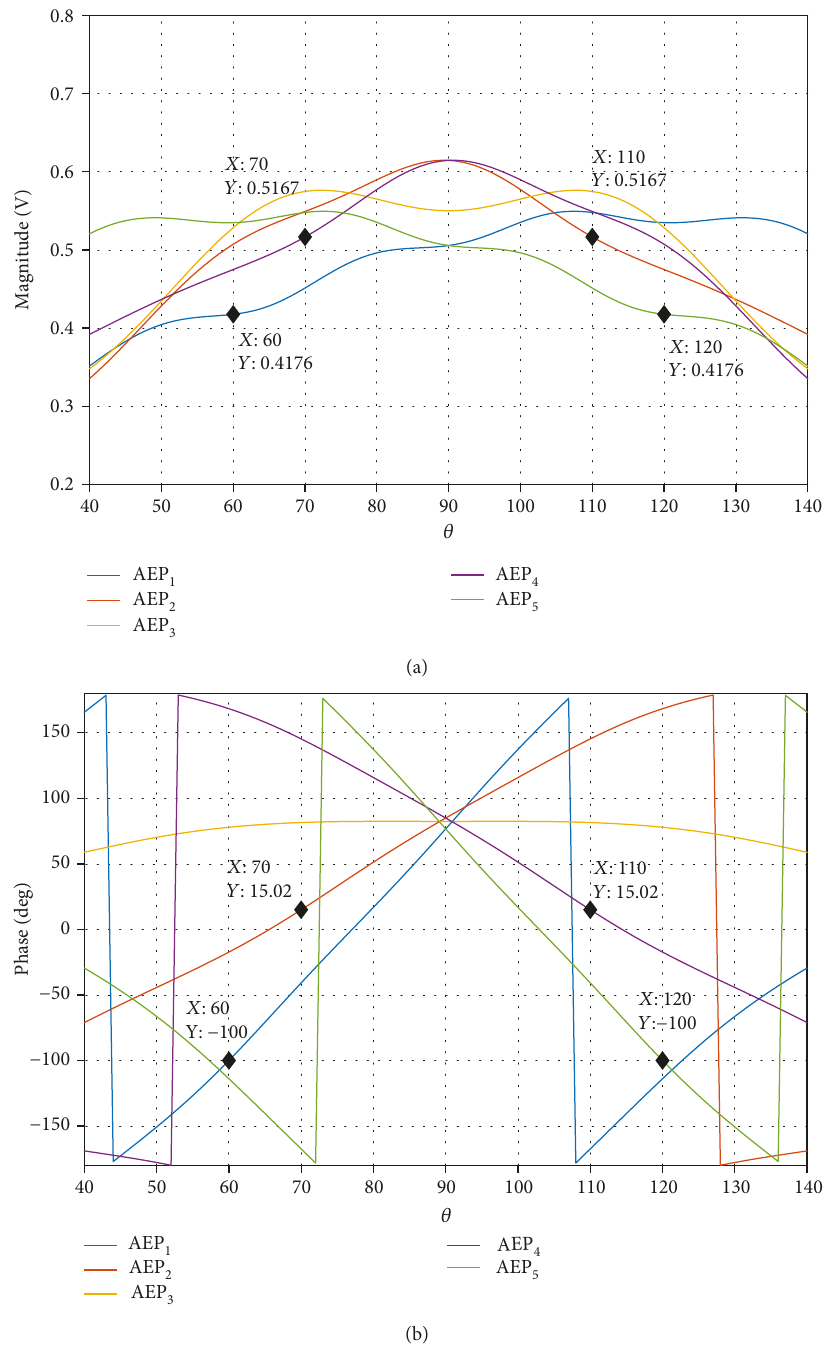
Figure 5: Active element pattern (H-plane) for an array of 5 λ /2 dipole antennas spaced λ /2 . (a) Magnitude. (b)